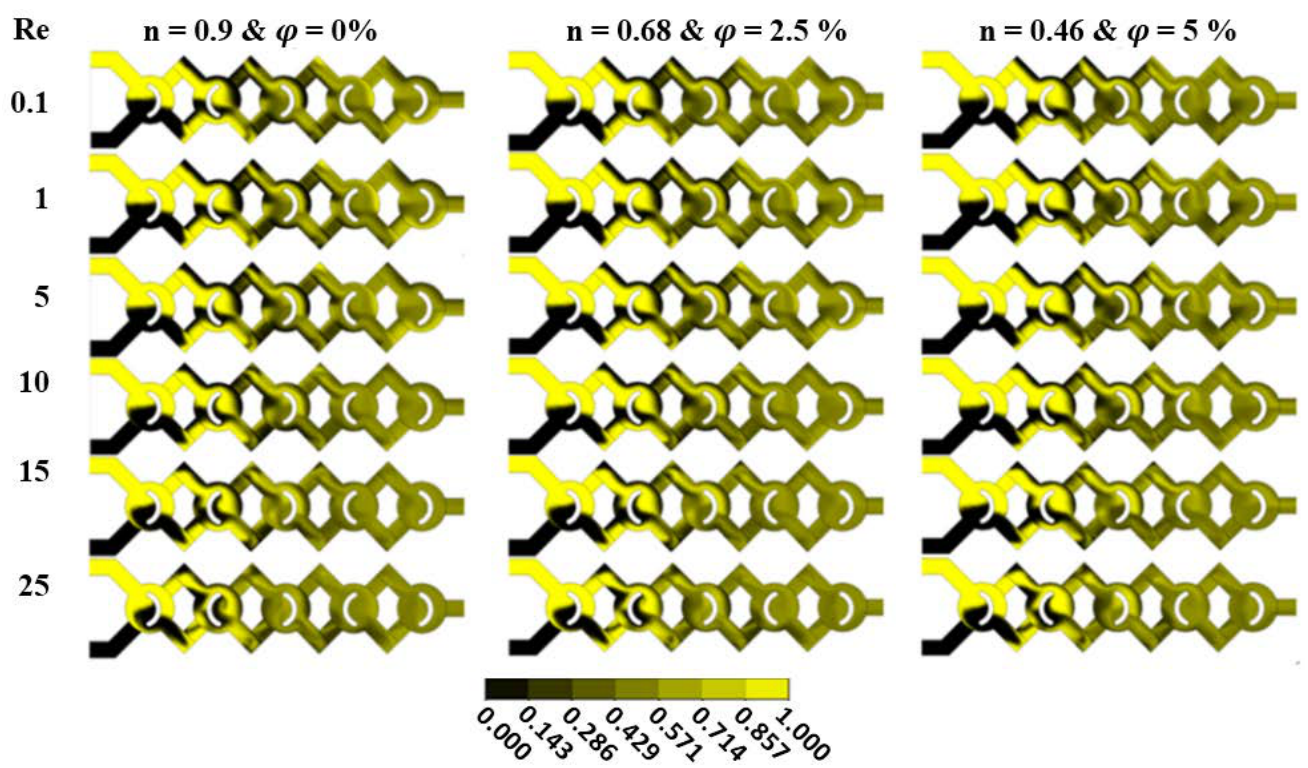
Figure 7. Mass fraction contours at various Reynolds numbers with different fluid concentrations (φ = 0.5 to 5%).